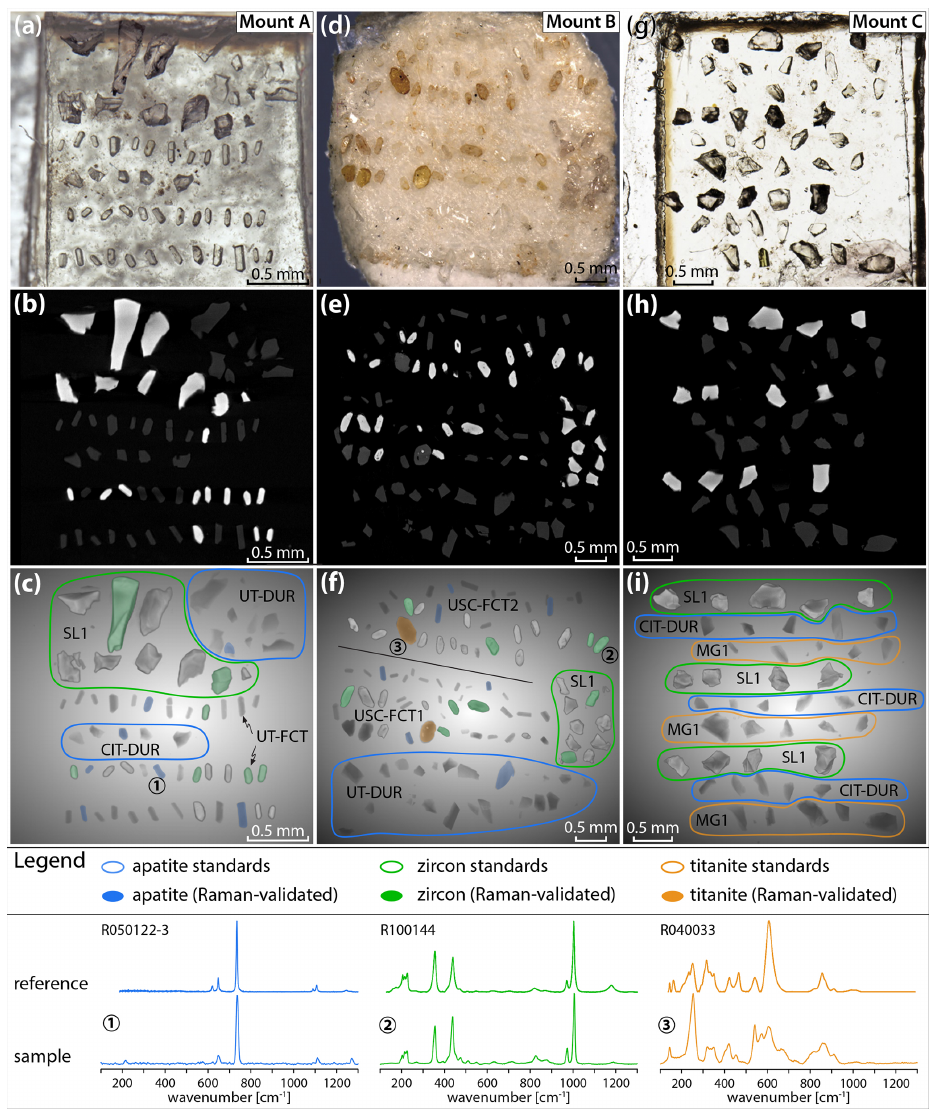
Figure 2. Transmitted light micrographs (a, d, g) , microCT slices (b, e, h) , and microCT volume renderings (c, f, i) of Mount A, Mount B, and Mount C. MicroCT slices show a large contrast between zircon grains (brighter) and apatite and/or titanite grains (darker). Grayscale value and grain relief in 3D renderings are distinct for different mineral phases. The 3D renderings show Raman-validated grains highlighted and known standard shards circled in blue (apatite), green (zircon), and orange (titanite). Baseline-corrected Raman spectra of representative grains and reference spectra from the RRUFF database (including record numbers) are shown below the images. Numbers in circles indicate the grains in the volume renderings which correspond to the sample Raman